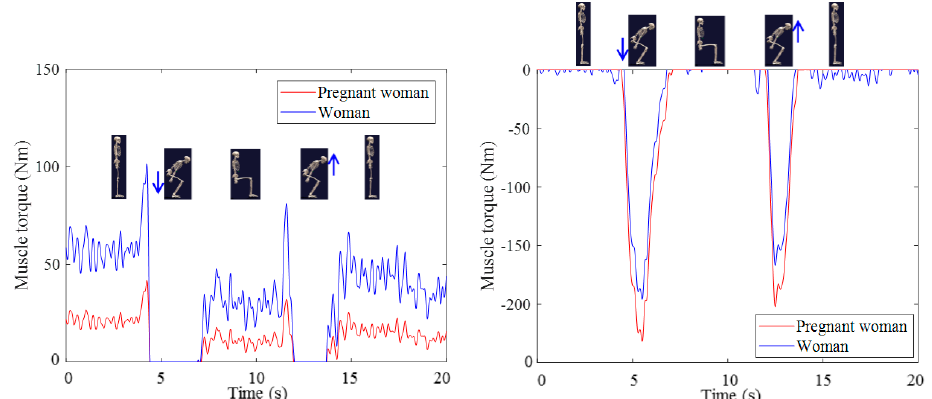
Figure 8. Muscle torque of the rectus abdominal (left) and erector spinae (right) comparing a pregnant woman and a non-pregnant woman during the sit-to-stand (STS) motions according to the musculoskeletal model.